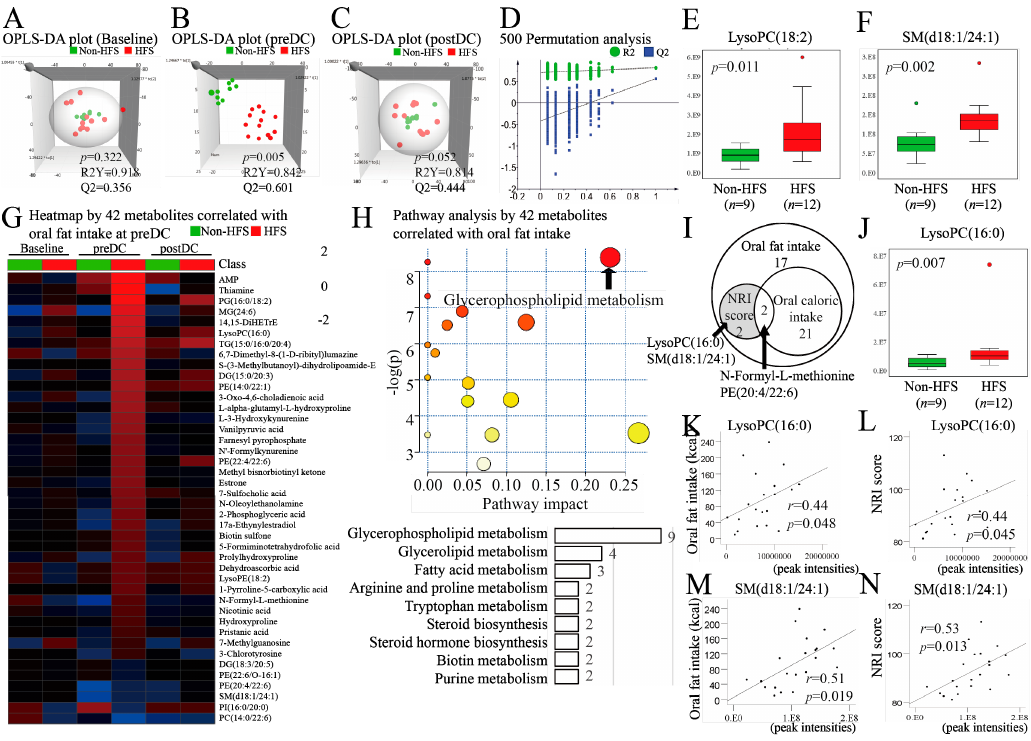
Figure 3. Metabolic analyses of oral fat intake-associated serum metabolites and their correlation with NRI score. ( A–C ) Orthogonal partial least squares discriminant analysis (OPLS-DA) score plot comparing HFS and non-HFS groups at baseline ( A ), preDC ( B ), and postDC ( C ); ( D ) 500 permutation validation plot for non-HFS compared with HFS at preDC. All permuted R 2 and Q 2 values on the left were lower than the points on the right, and Q 2 regression line had a negative intercept ( R 2 = 0.776, Q 2 = − 0.428, Y = − 0.542); ( E–F ) box plots for dysregulated pancreatic cancer-specific metabolites, log-transformed; ( G ) heat map for comparison by 42 metabolites correlated with oral fat intake in the HFS group compared with the non-HFS group at baseline, preDC, and postDC. The values used in the heat map are log 2 transforms of fold change values divided by baseline peak intensities; ( H ) pathway diagram of 42 oral fat correlated-metabolites significantly hit in the pathway analysis. ( I ) Venn diagrams reflecting metabolites significantly correlated in oral fat intake ( n = 42), oral caloric intake ( n = 23), and NRI scores ( n = 4) among 195 metabolites; ( K–N ), LysoPC(16:0) and SM(d18:1/24:1) significantly correlated with oral fat intake and NRI score (Pearson’s r correlation analysis). OPLS-DA, orthogonal partial squares discriminant analysis; non-HFS, non-supplemented group; HFS, high fat supplement group; preDC, day before